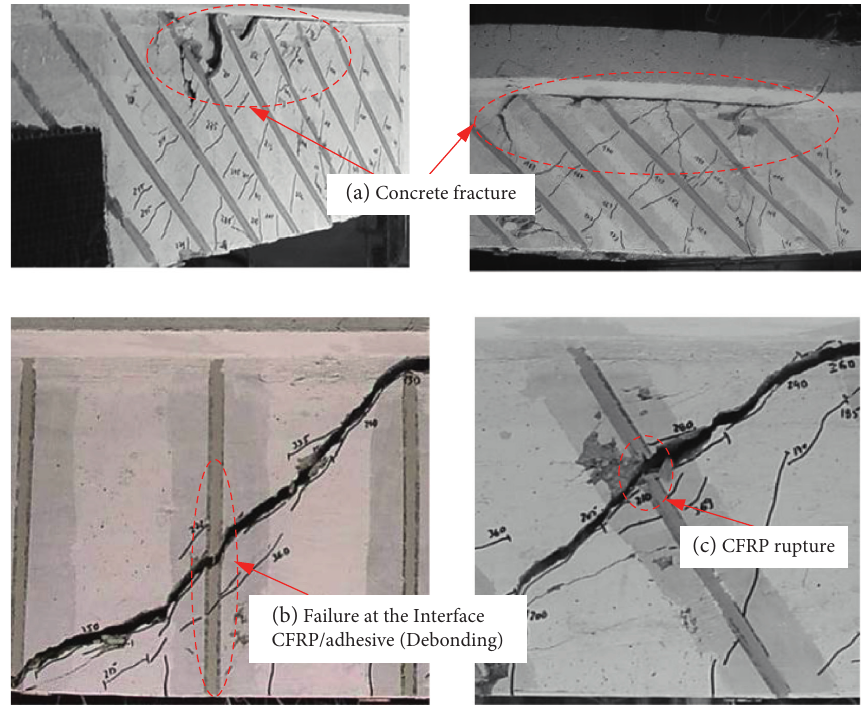
Figure 5: Failure modes (a, b, and c) of the RC beams shear strengthened with NSM CFP laminates